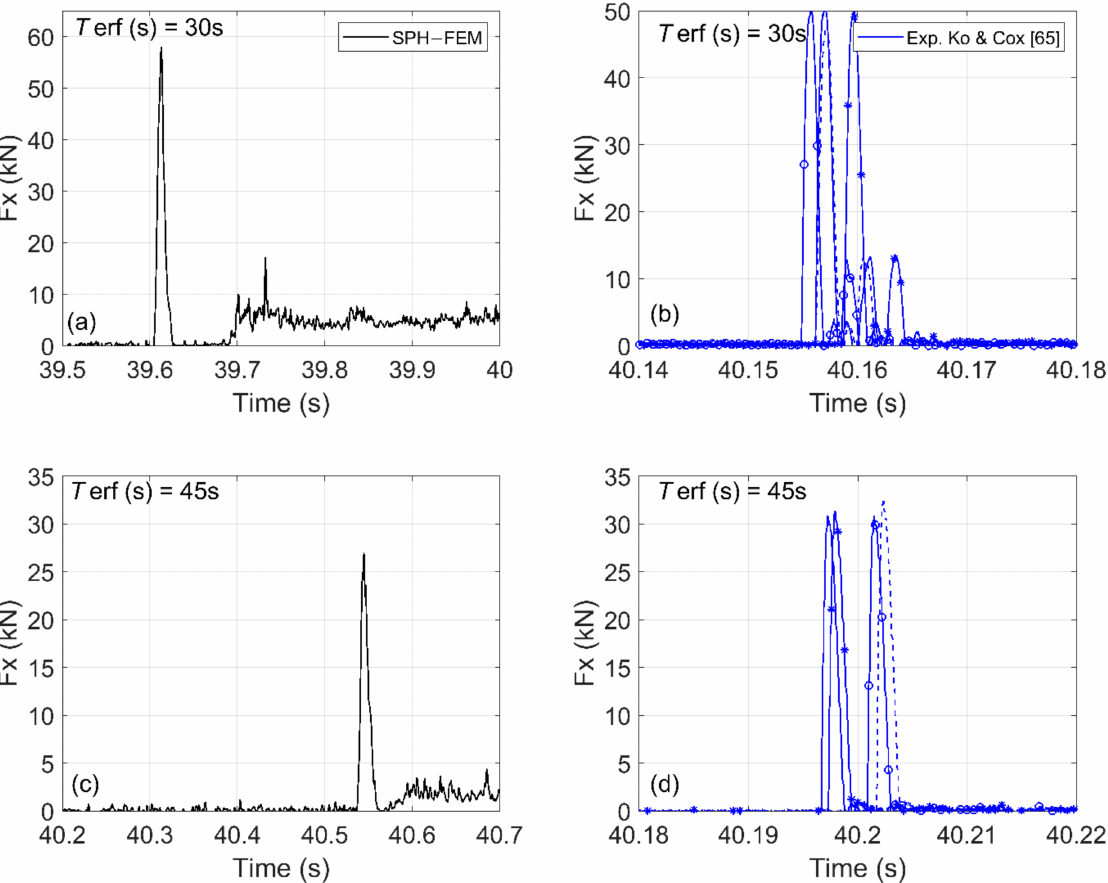
Figure 7. Comparison of the debris impact forces: experimental tests [65] and numerical simulations for h 1 = 2.496 m, and two wave cases with T erf = 30 s and 45